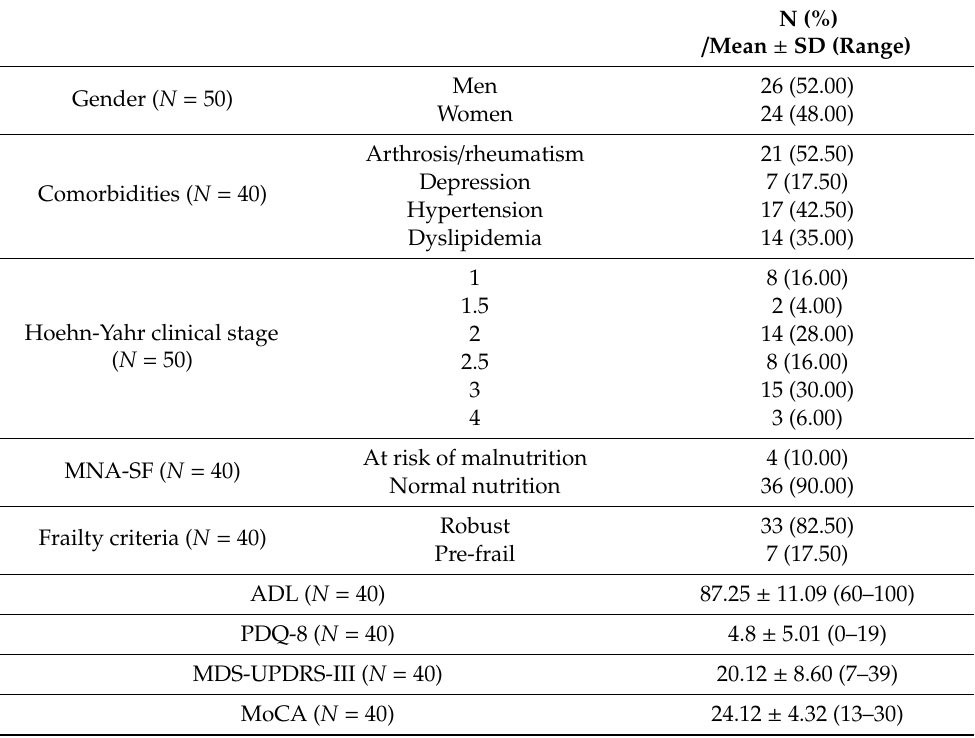
Table 1. Demographic data, comorbidities, and clinical status of patients with Parkinson’s disease.